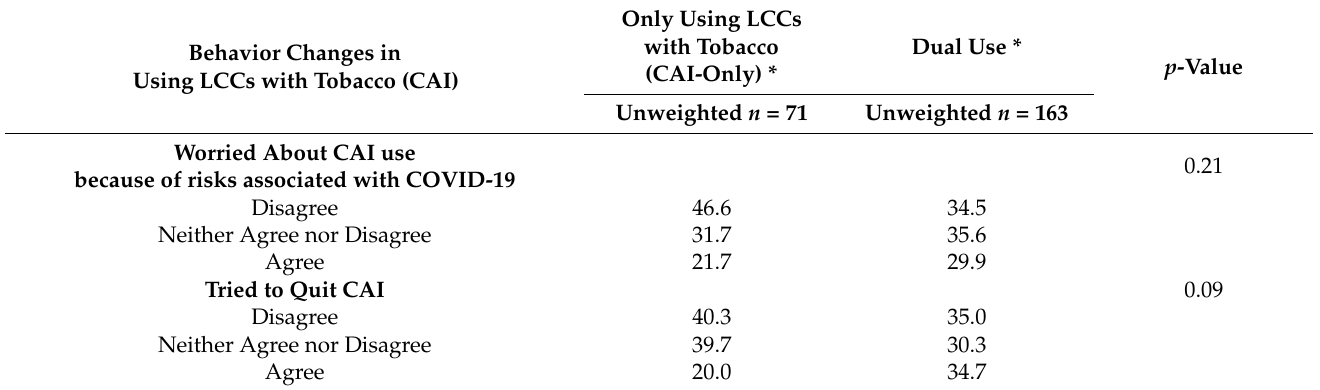
Table 2. Behavioral changes in LCC use during COVID-19 pandemic among past 6 month